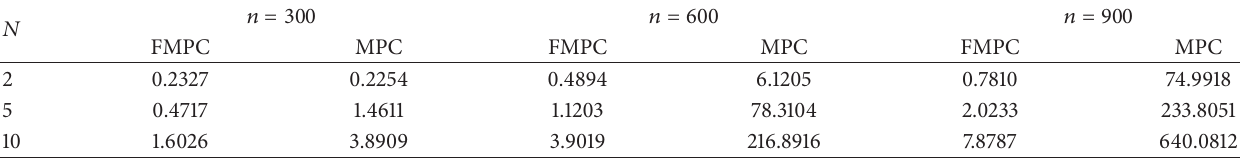
Table 1: Comparison of CPU times for oscillating spring-mass problem.